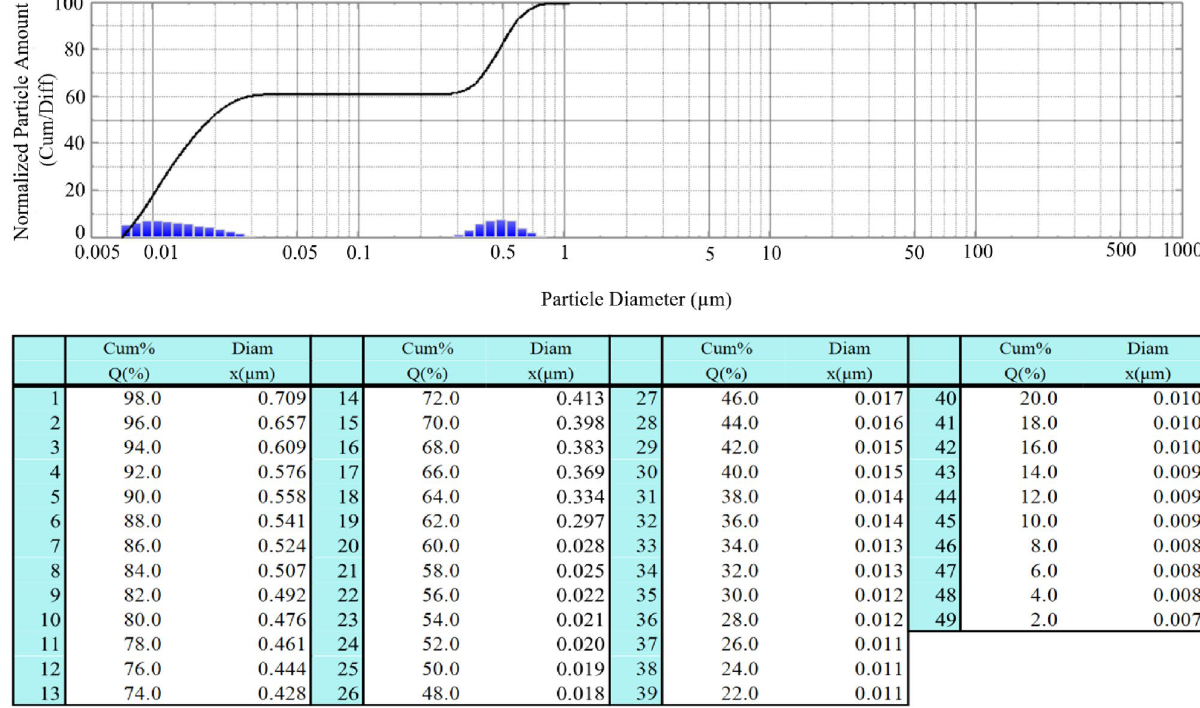
Figure 5. Silica particle size distribution for the sample water + SiO 2 immediately after the preparation of the liquid.